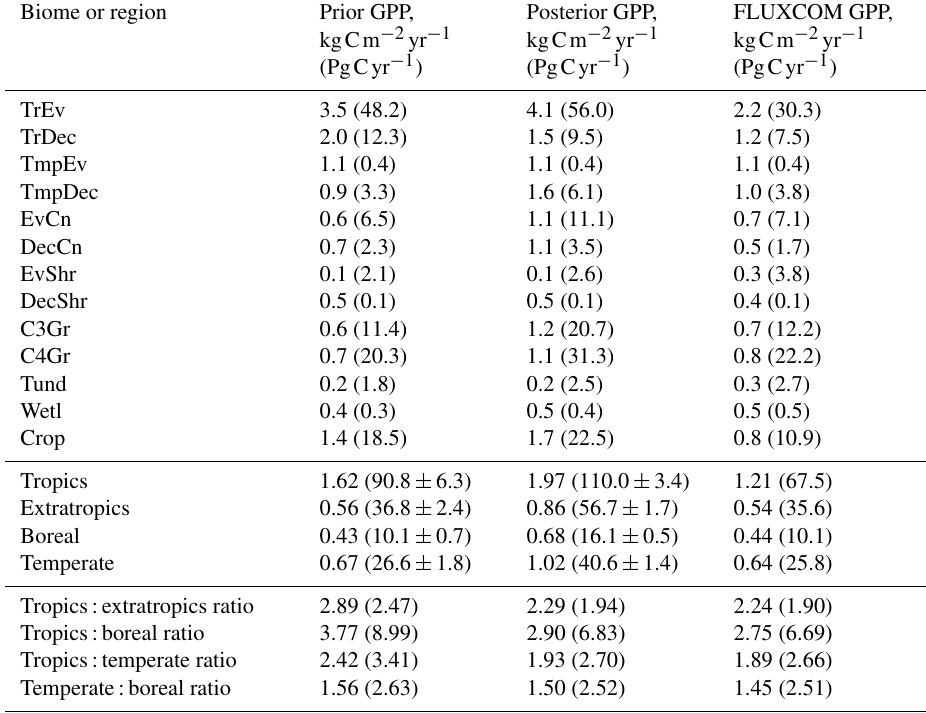
Table B1. Estimated GPP per biome and latitudinal region, given as GPP rate and total annual GPP (in brackets). Biomes are defined by the spatially dominant PFT as shown in Fig. A1. The tropics are defined as the region between 30 ◦ S and 30 ◦ N and the extratropics is defined as all latitudes outside of the tropics. The boreal region is defined as north of 54 ◦ N. The temperate region is defined as south of 30 ◦ S and 30–54 ◦